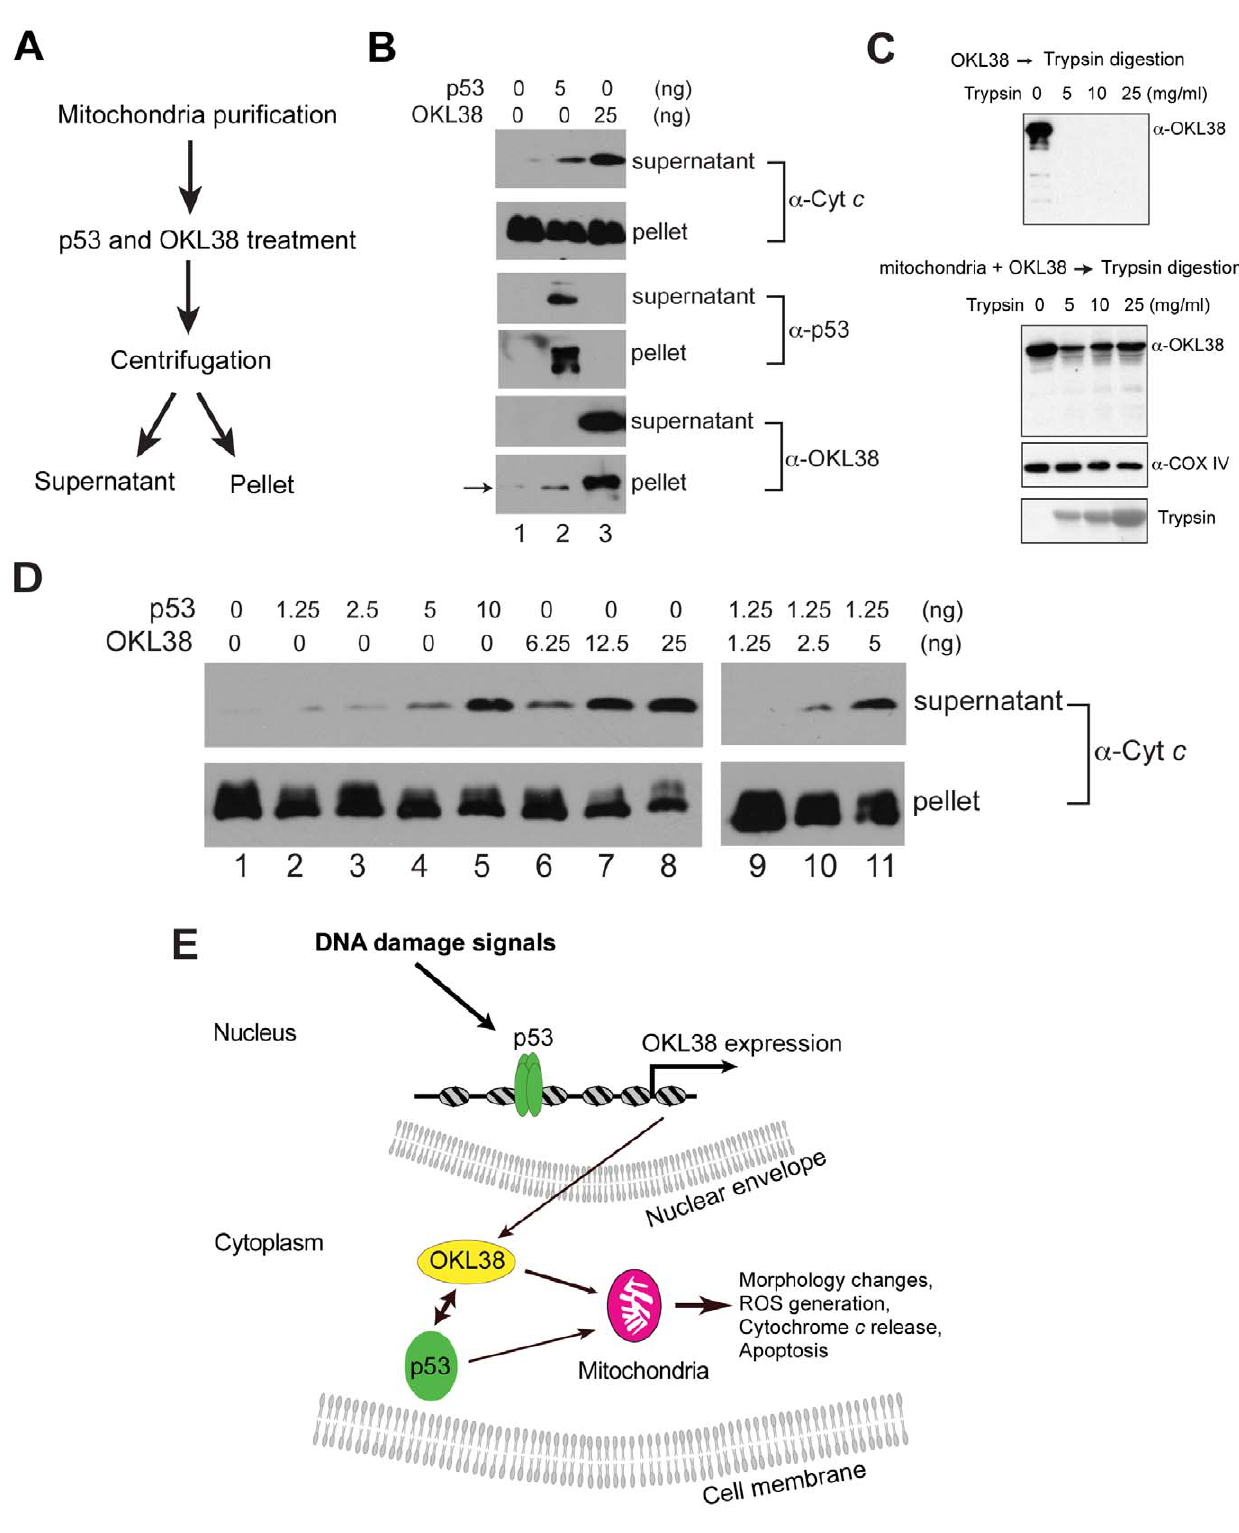
Figure 6. OKL38 and p53 induced cytochrome c release from purified mitochondria invitro . (A) Biochemical scheme used to analyze the effect of p53 and OKL38 on cytochrome c release from mitochondria. (B) Effects of p53 and OKL38 on cytochrome c release (top 2 panels), and the detection of p53 (middle 2 panels) and OKL38 (bottom 2 panels) in both soluble and pellet fractions by Western blot. Arrow denotes low levels of endogenous OKL38 in mouse liver mitochondria. (C) Western blot analyses of OKL38 digestion by trypsin without (upper panel) or with prior incubation with mitochondria (Lower panel). COX IV protein was monitored to show that mitochondrial protein is protected from trypsin digestion. The amount of trypsin in the reaction was detected by Ponceau S staining. (D) Western blot analyses of the amount of cytochrome c in the supernatant and pellet fractions after mitochondria were incubated with p53 and/or OKL38 at various concentrations. (E) A model of the function of